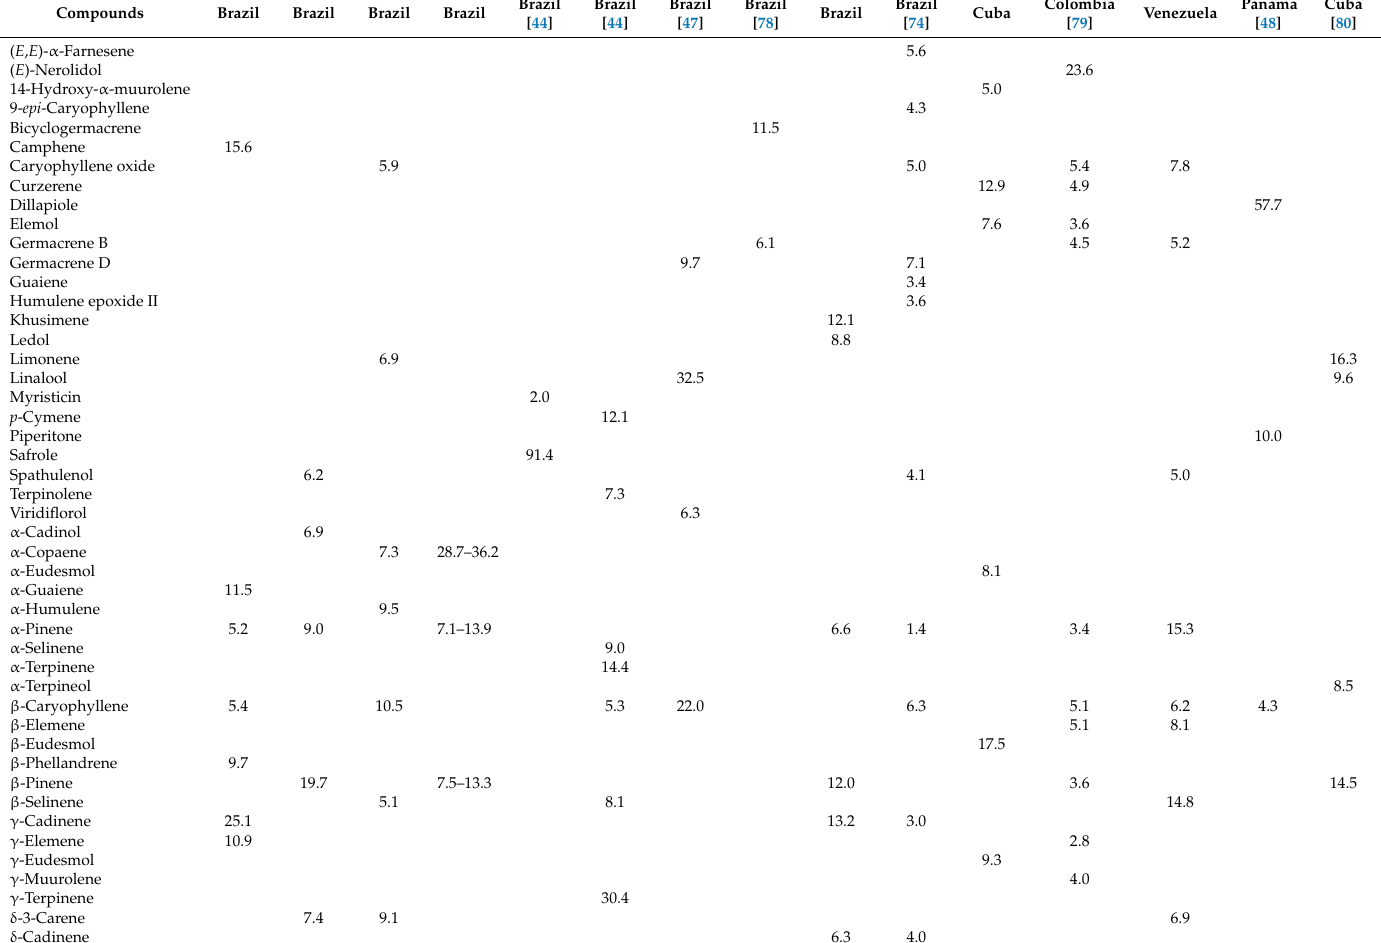
Table 18. Chemical compositions (%) of Piper hispidum Sw. and Piper hispidinervum C.DC. essential oils.